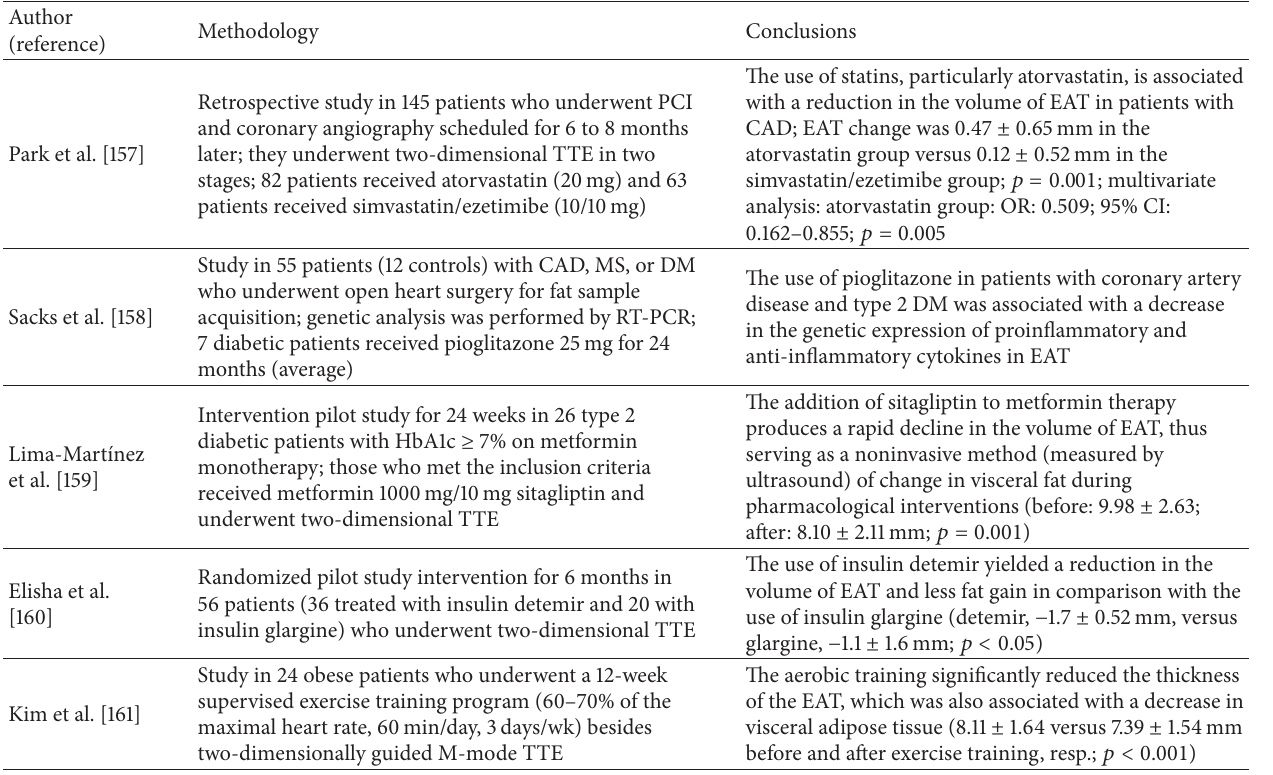
Table 3: Studies of therapeutic measures to decrease the epicardial fat